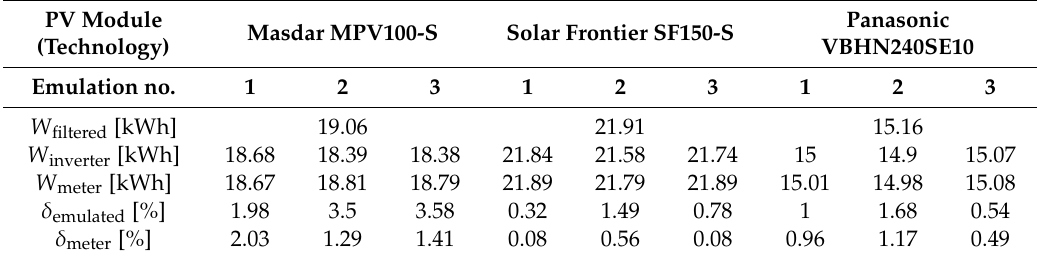
28 March 2018, and 1 May 2018. Table 5. Results of fast PV power emulation of the 6 kW PV plant for 2 September 2018.